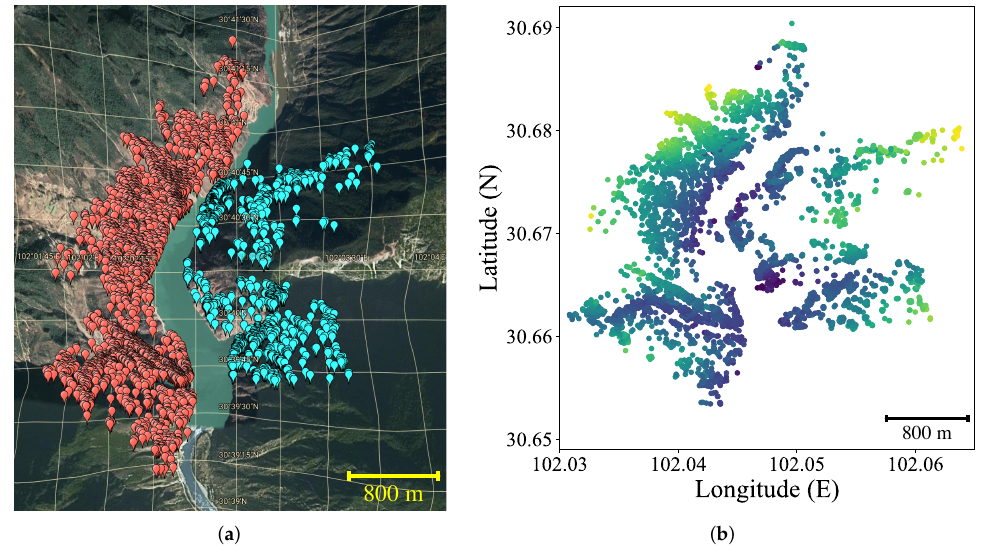
Figure 1. Multi-perspective views of the studied slopes. For Figure ( a ), the monitored locations on west and east slopes above the dam are marked as red and blue respectively; for Figure ( b ), the points are colored by elevation, and the lower the